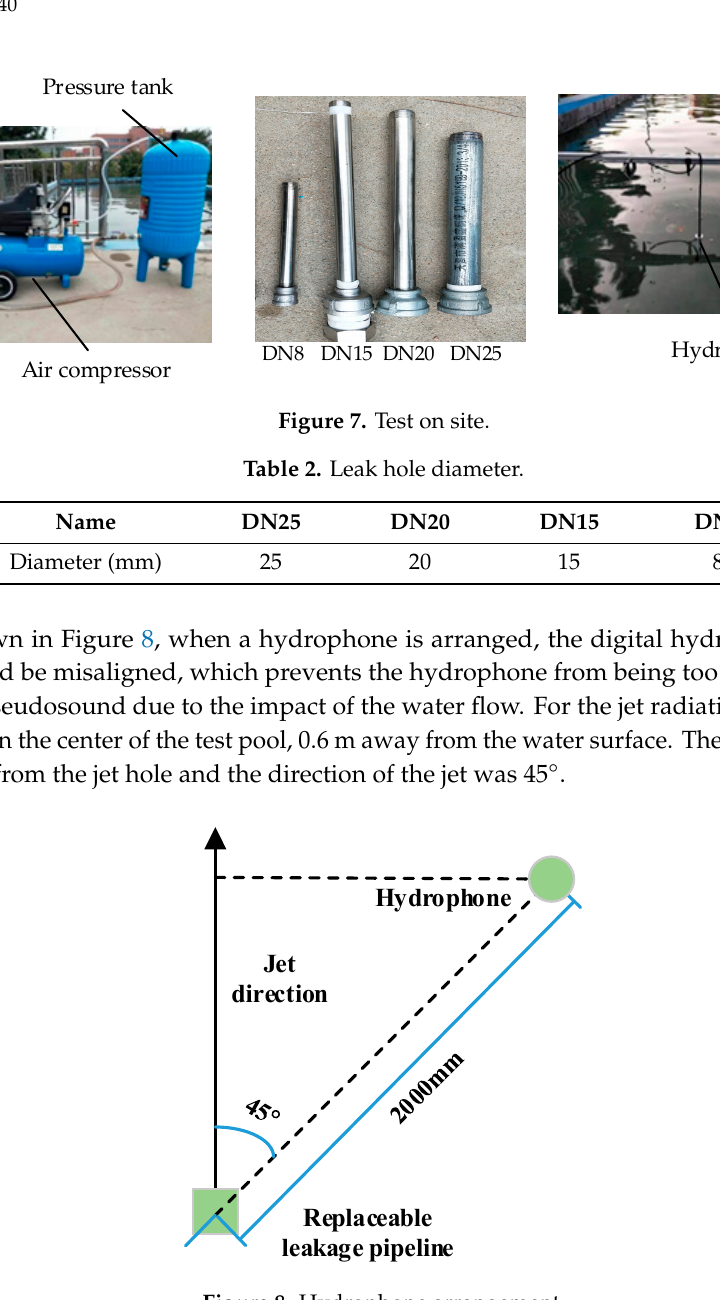
Figure 8. Hydrophone arrangement.